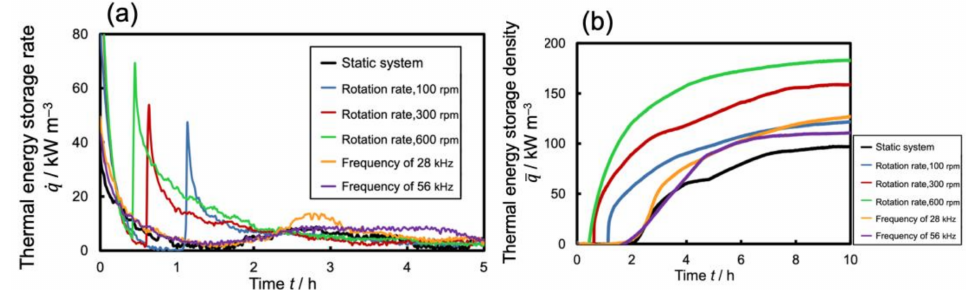
Figure 12. Time evolutions of thermal energy storage rate and density in all systems. ( a , b ) depict the thermal energy storage rate and density,